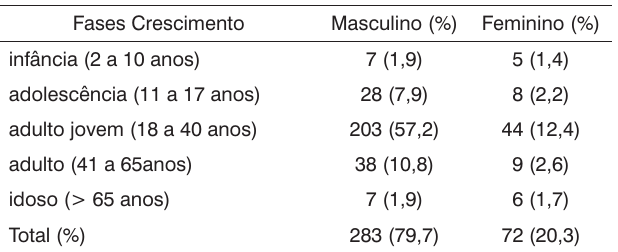
Tabela 1. Distribuição dos pacientes em relação às fases de cresci- mento à época do